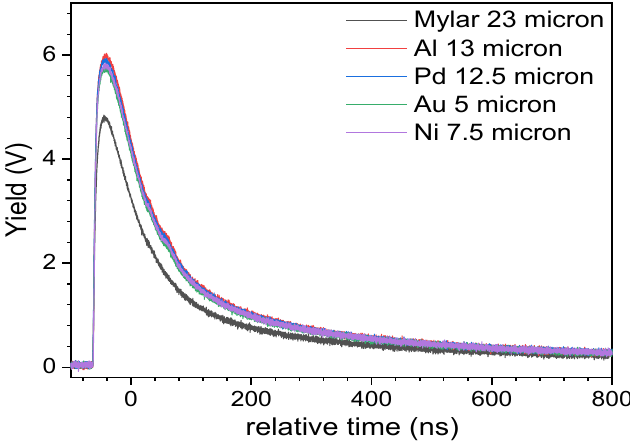
Figure 17. Gamma detector scintillation signal for different target materials .